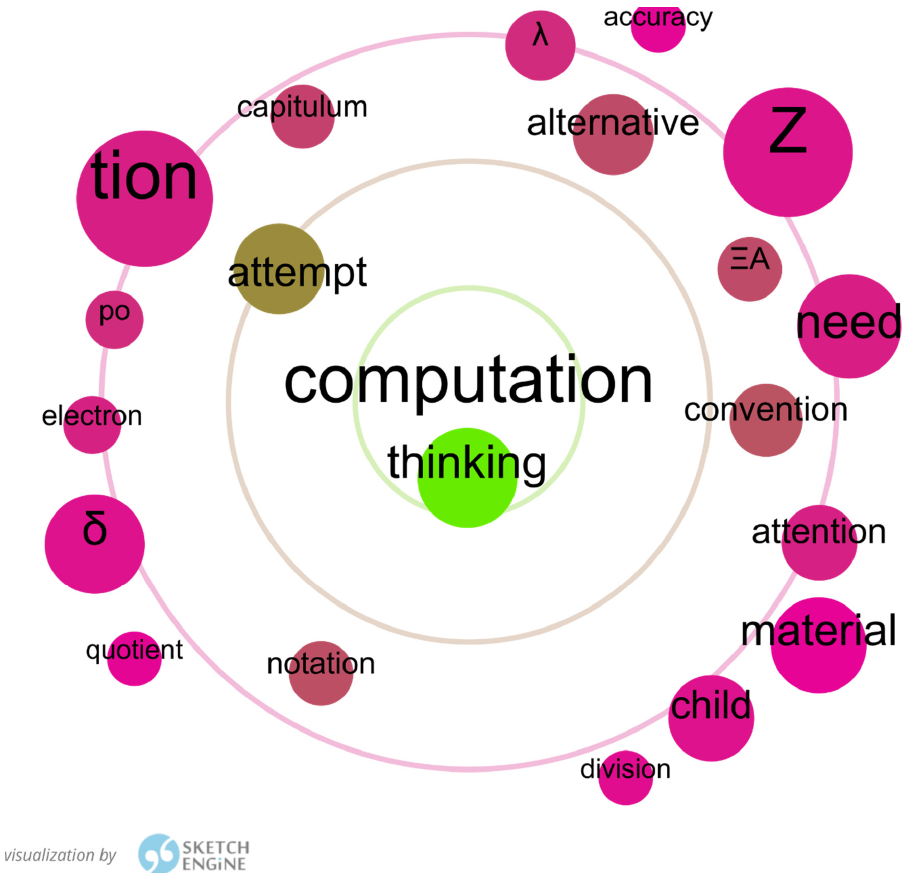
Figure 7. Terms semantically similar to “computation” in Turing’s corpus.